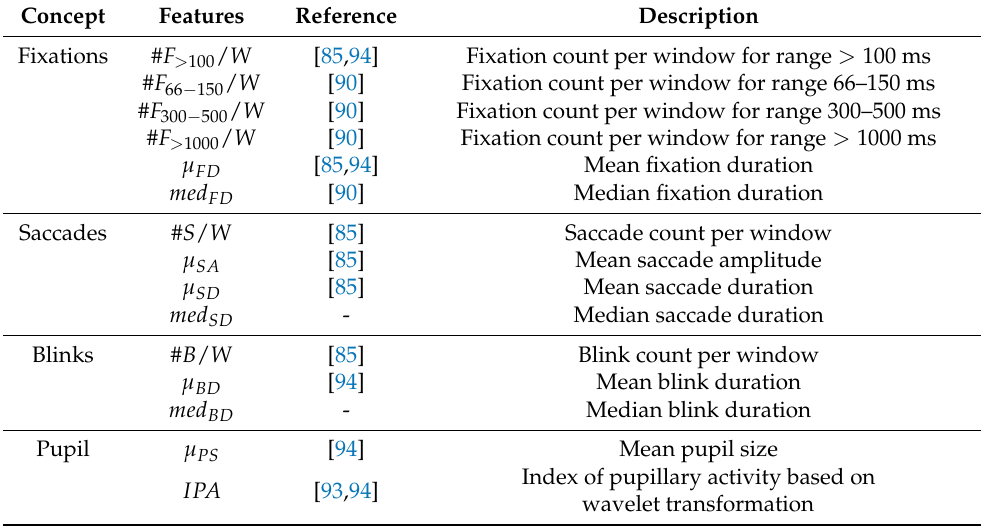
Table 2. List of extracted expert and statistical eye tracking